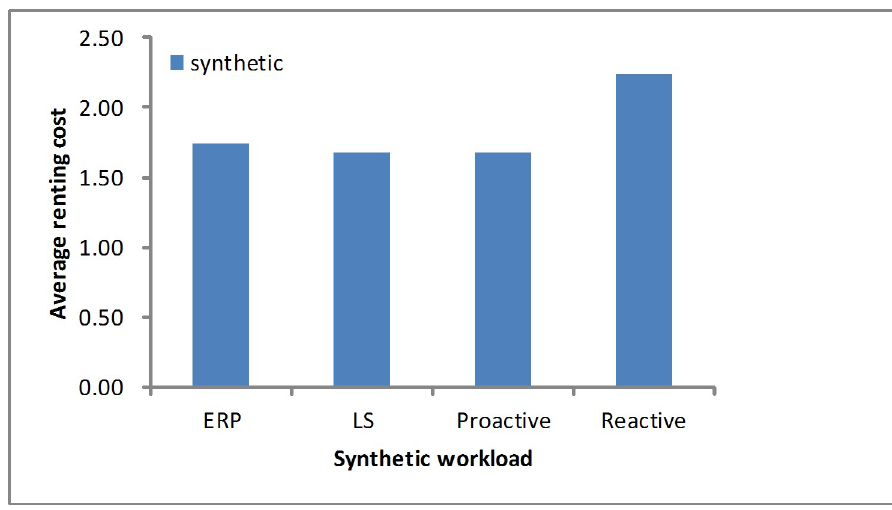
Fig 8. Average renting cost in the synthetic